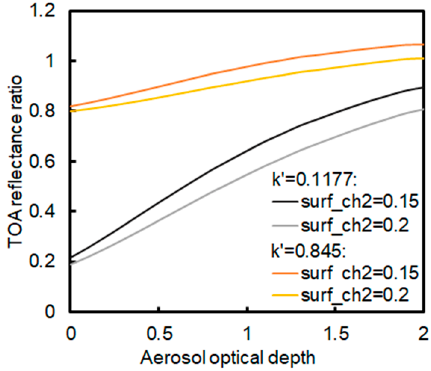
Figure 5. The simulated TOA reflectance ratio of 0.63 to 0.85 μ m as the function of AOD at 0.55 μ m when the solar zenith angle is 22.14°, satellite zenith angle 48°, and relative azimuth angle − 156.41°. The “surf_ch2” indicates a surface reflectance at 0.85 μ m. “ 𝑘′ = 0.1177 ( 𝑘′ = 0.845)” means that the surface reflectance ratio of 0.63 to 0.85 μ m is 0.1177 (0.845).